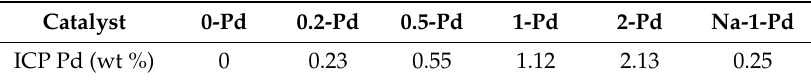
Table 3. Pd loading of